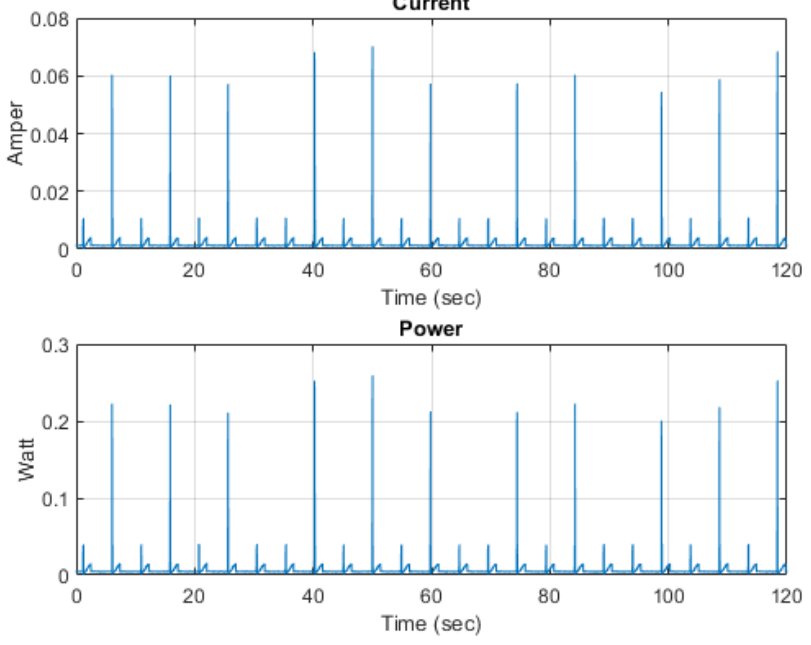
Figure 18. AquaBit current and power consumption during sampling.